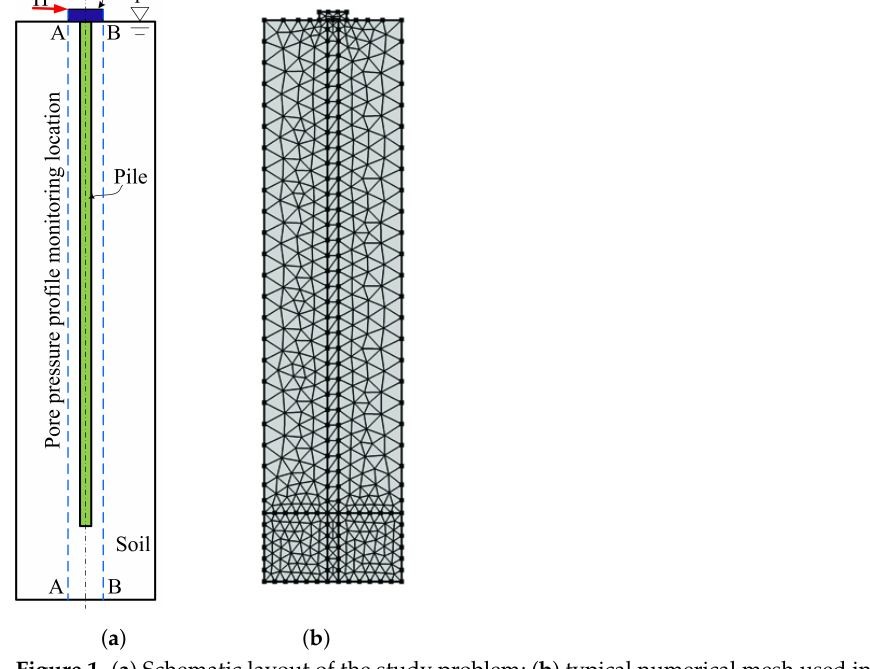
Figure 1. ( a ) Schematic layout of the study problem; ( b ) typical numerical mesh used in the analysis.